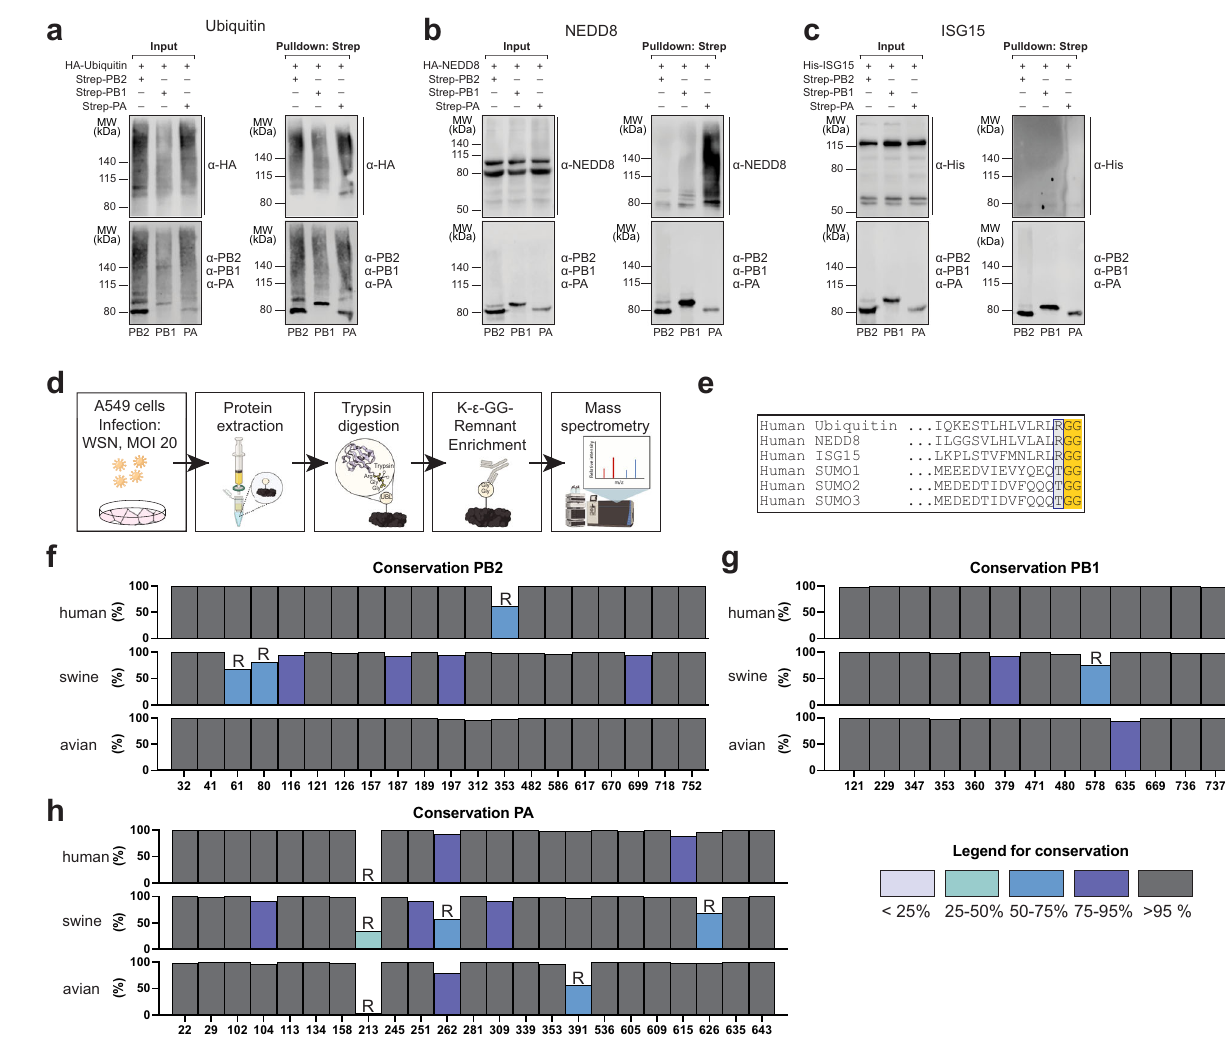
Fig. 1 | Identi fi cation of site-speci fi c UB modi fi cations in the IAV polymerase. a – c Western blot analysis of ubiquitin (UB), NEDD8 and ISG15 modi fi cation of the IAVpolymerasesubunits. A549 (UB)orHEK293-T (NEDD8, ISG15)weretransfected with expression plasmids for strep-tagged polymerase subunits (PB2, PB1, or PA), respectively, together with plasmids for the expression of ubiquitin-like modi fi ers (UBLs) bearing an HA- or His-tag. UBL-modi fi ed polymerase subunits were pre- cipitatedunderdenaturingconditionsusingStrep-Tactin®boundsepharosebeads. UBL modi fi cation was detected by western blot using the indicated antibodies. Representativeblotsof threeindependentexperiments areshown.MW,molecular weightmarker. d Experimentaloutlinefortheidenti fi cationofdi-glycylatedlysines using a di-glycyl-speci fi c immunoselection coupled to mass spectrometry analysis